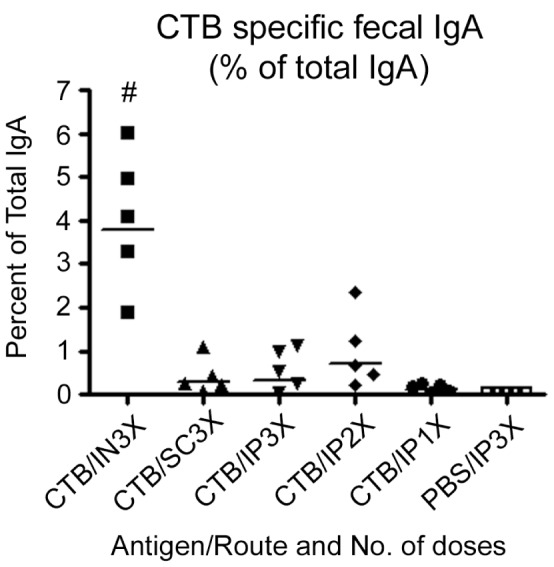
Relative abundance of fecal CTB-specific IgA at 14 days following the final/only immunization via the intranasal (IN), subcutaneous (SC), or intraperitoneal (IP) route.For each fecal extract, the relative abundance of CTB-specific IgA is expressed as a percentage of the total IgA in that fecal extract. Each symbol represents an individual mouse, and horizontal bars represent the geometric mean for that group (n = 5). Statistical differences between groups were analyzed using ANOVA with Tukey-Kramer post-test analysis (# P<0.001 versus all other groups).